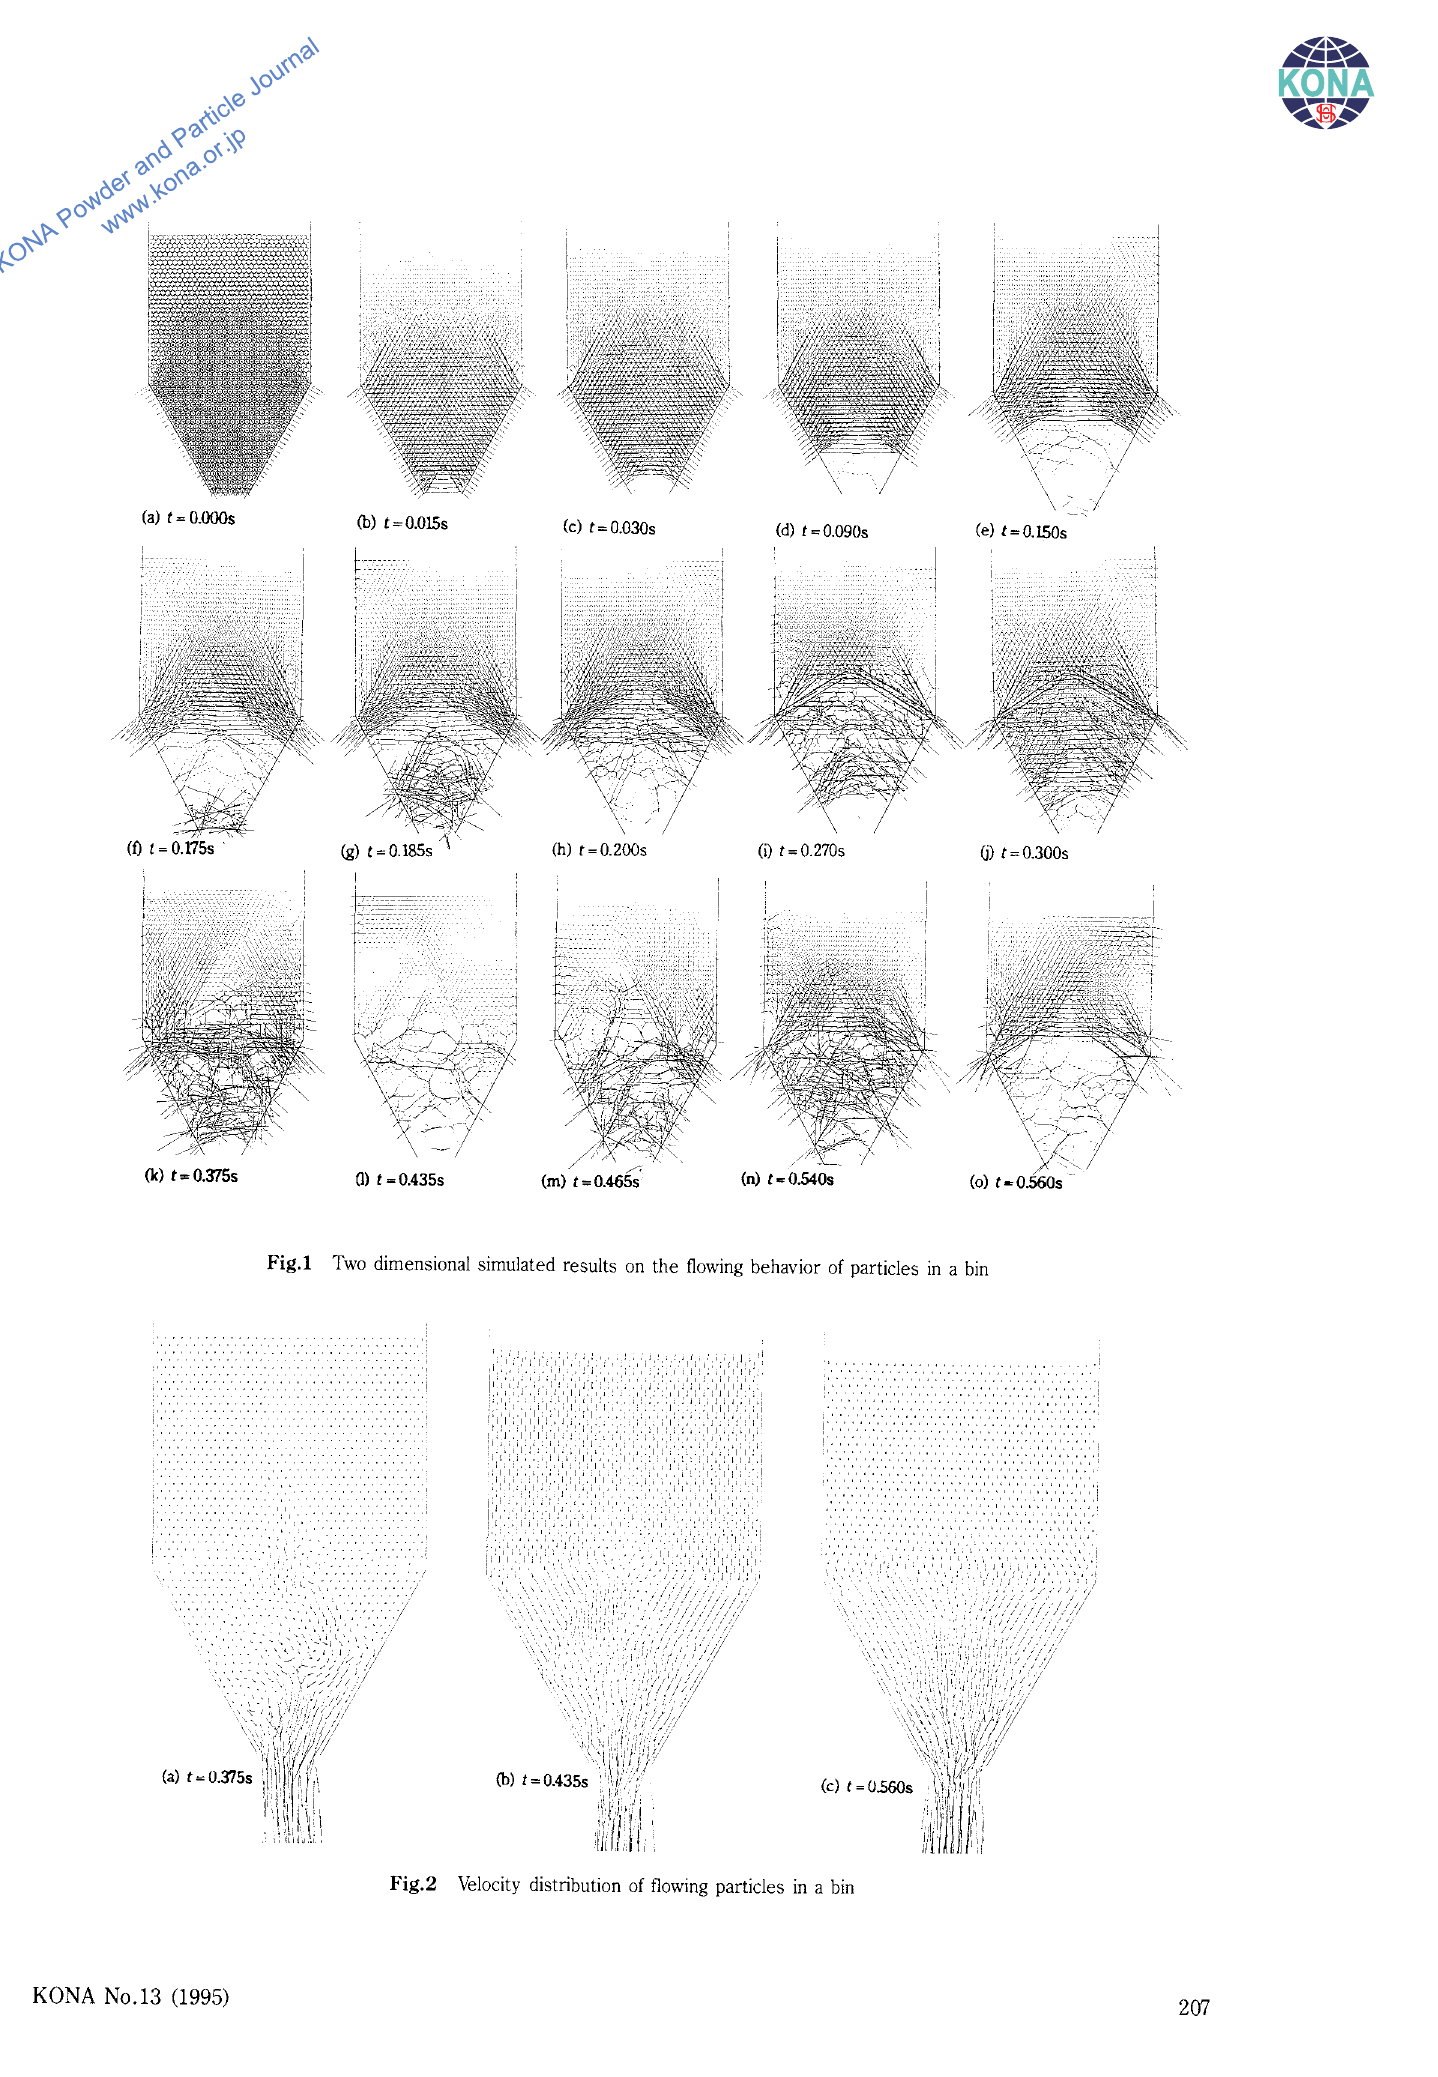
Fig.2 Velocity distribution of flowing particles in a